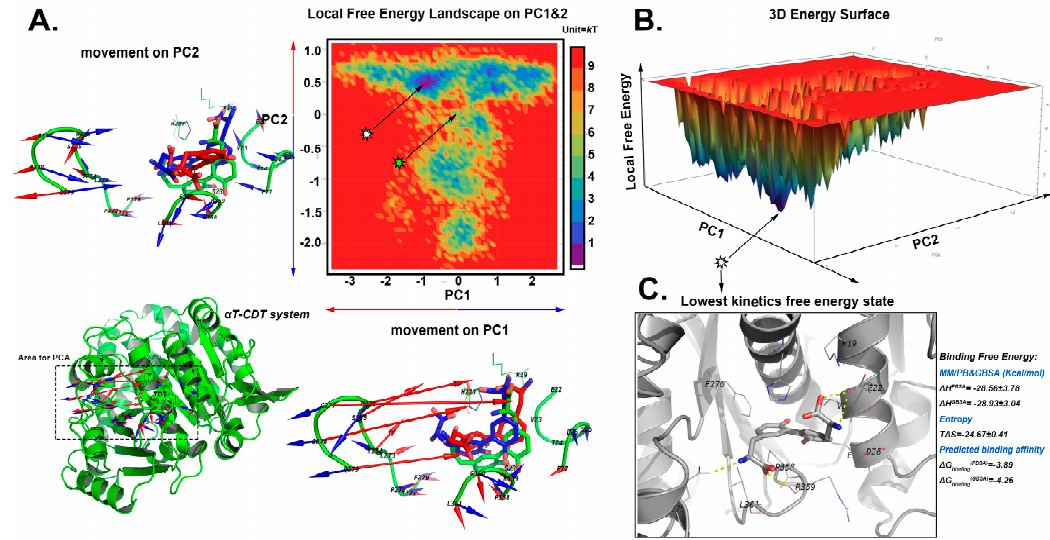
Figure 7. The search of lowest free energy poses in α T-CDT MD system by local free energy landscape (LFEL) and MM/GB and PBSA calculations. ( A ) The 2D LFEL heat map. The green star shows the docked conformation with the coordinate (0, 0), and is viewed as a reference structure. The highest local free energy was defined as 10 kT, which can barely be sampled from all the conformational space. The bottom left shows the areas for which PCA calculations carried out. The docked pose is in green. The movements on PC1 and 2 vectors from the production phase simulations are shown as a porcupine plot alongside with the axis. The scales of arrows are proportional to the scale of movements observed along each PC. The movements towards the positive direction of PC are in blue, and that of the negative direction are in red. CDT are in sticks; blue red sticks represent the minimum and maximum conformations observed by the PC vectors and surrounding residues are shown as cartoon. The docked pose is coloured in green. ( B ) The converted 3D surface of FEL with the same colour code as shown in panel A. ( C ) The collected state with lowest kinetic free energy. The protein is in white cartoon, CDT are shown by sticks, and the nearby residues are shown as white lines. The hydrogen bonds are indicated by yellow dashes. The collected conformation and the nearby 50 frames were used for calculating the binding free energy, which are displayed nearby panel C.